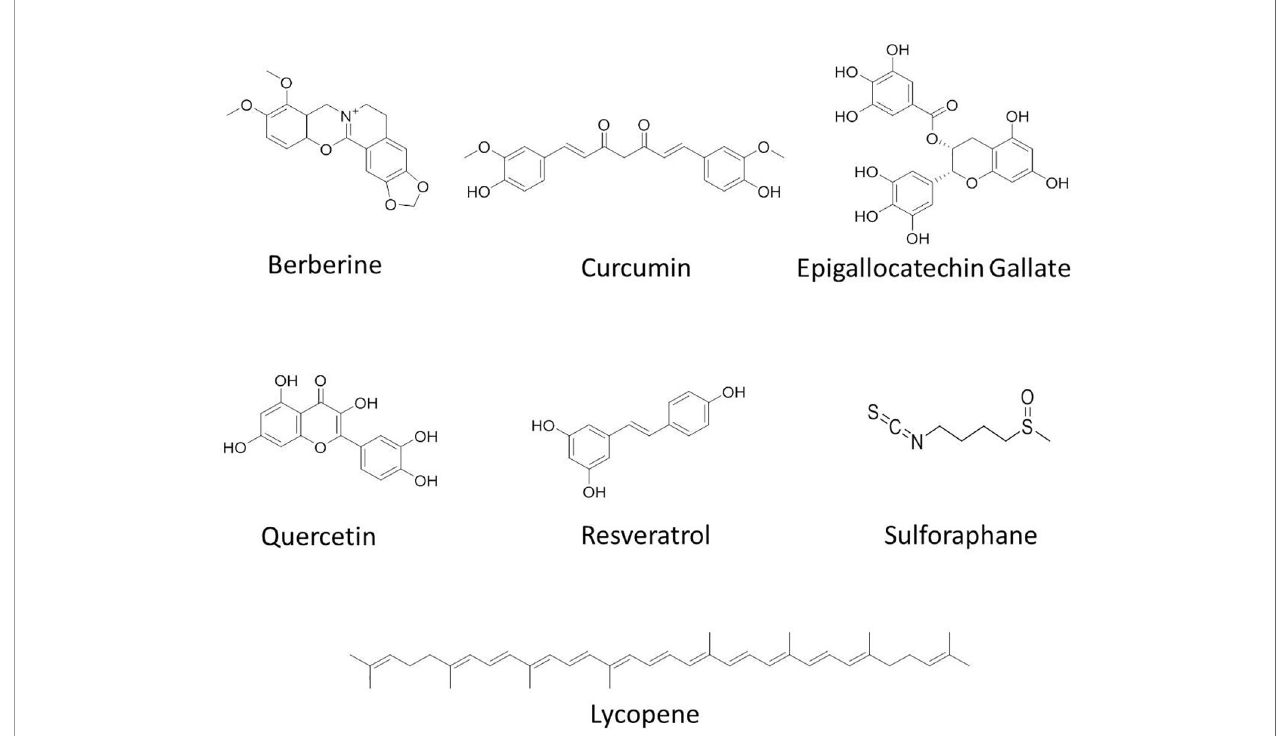
FIGURE 2 | Chemical structures of some anticancer agents in clinical